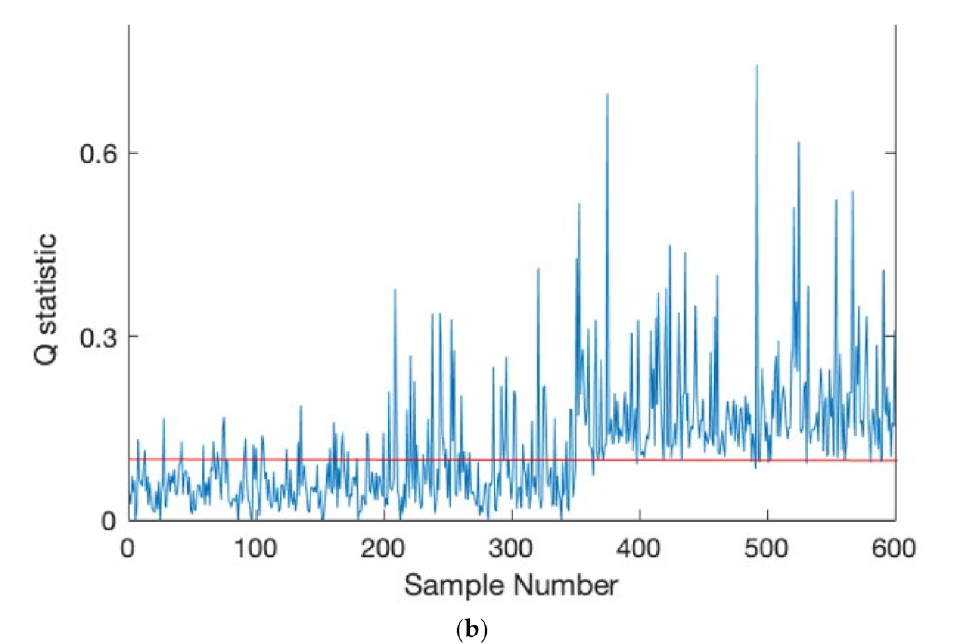
Figure 9. ( a ) KLPP-based T 2 chart fault detection results in quality non-pertinent; ( b ) KLPP-based Q chart fault detection results in quality